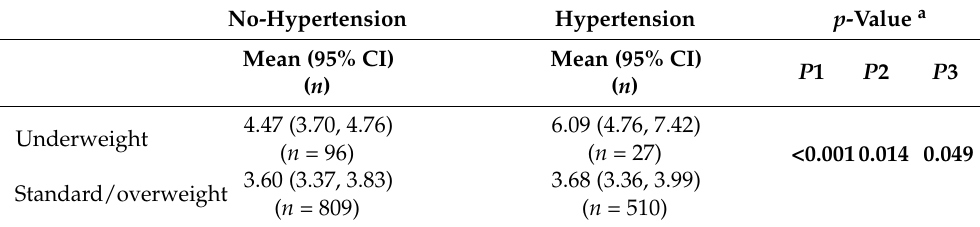
Table 5. Interactions between body size and hypertension on GDS in females.